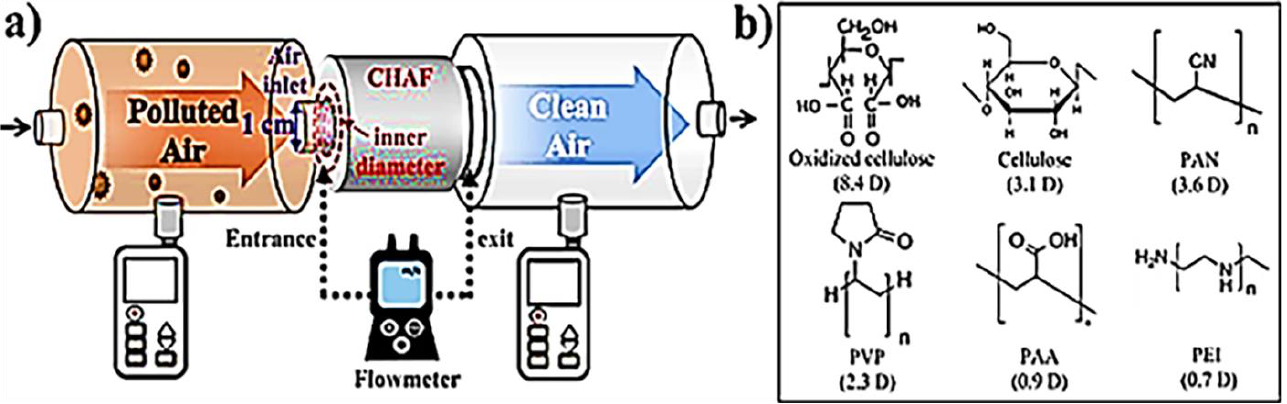
Figure 9. ( a ) Schematic of an air filtration system equipped with cylindrical hollow air filter (CHAF), flow meter, and PM detectors; ( b ) Structural formulas and dipole moments of various polymers [195]. Reproduced with permission from ACS.